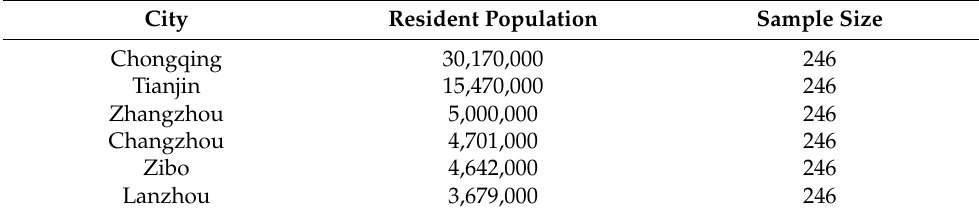
Table 2. Resident population and sample size of six cities.